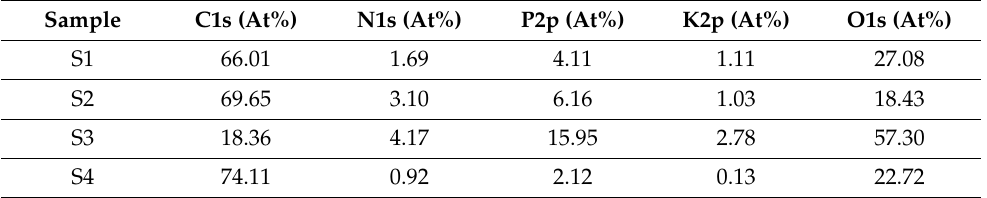
Table 2. Survey scan results of C1s, N1s, P2p, K2p and O1s core level XPS spectra of soy materials. Sample C1s (At%)